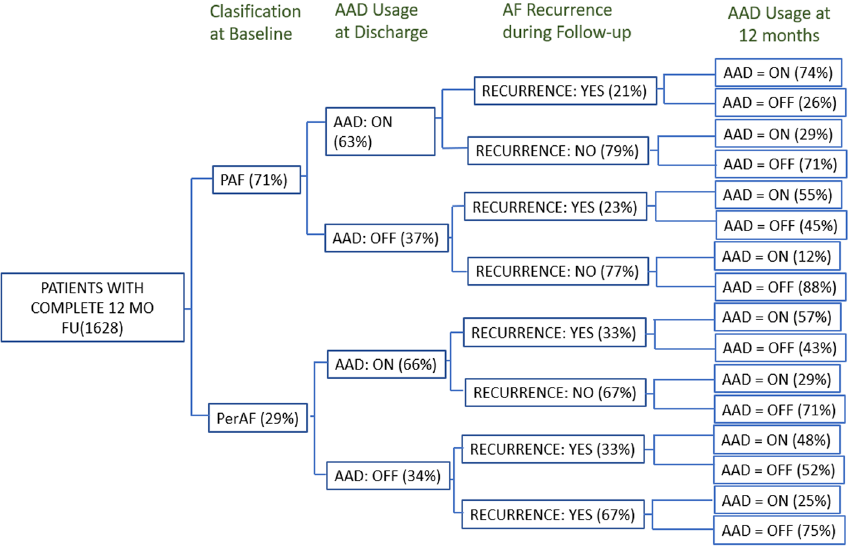
Figure 6. Flow-chart showing AF recurrence data according to type of AF, AAD at discharge and AAD usage at the final follow-up for the entire population. (see text for